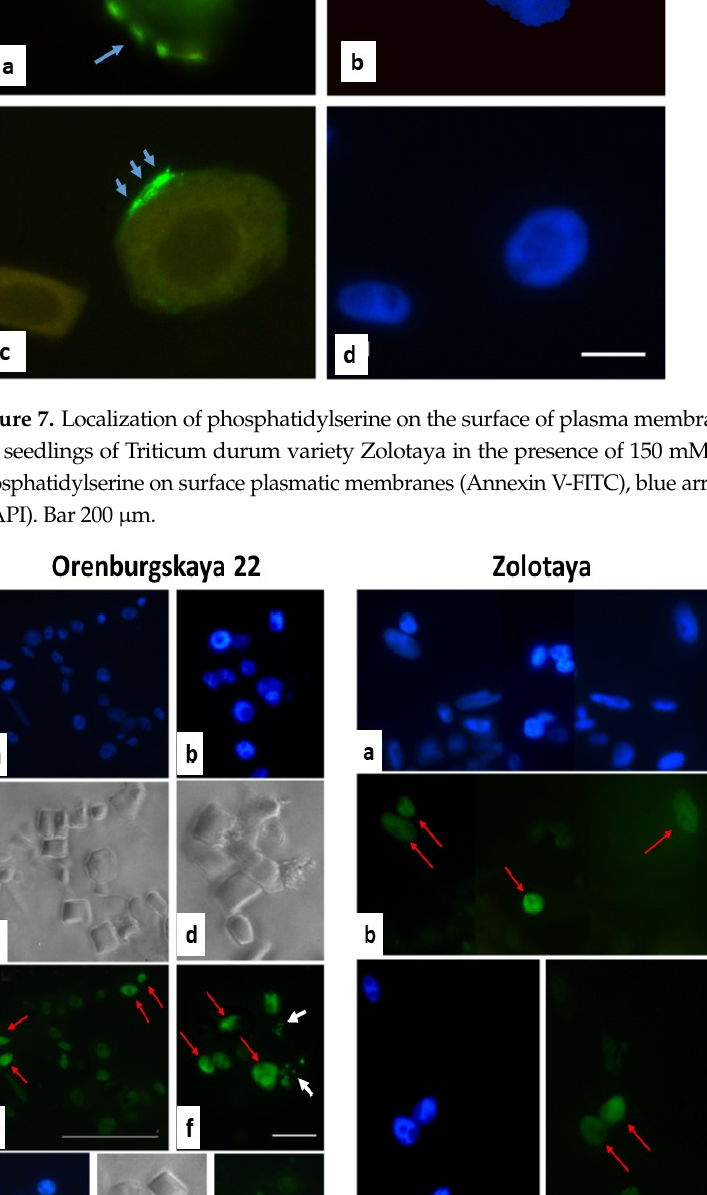
Figure 8. DNA breaks in the nuclei of cell tissues of the roots of 4-day-old seedlings of Triticum aestivum variety Orenburgskaya 22 and Triticum durum variety Zolotaya in the presence of 150 mM NaCl, detected by the TUNEL method. ( a , b , g )—Root cell nuclei (DAPI); ( c , d , h )—phase contrast of cells; ( e , f , i )—nuclei, micronuclei (arrows—white), and chromosomes with DNA breaks (arrows— red). Bar 200 μ m.